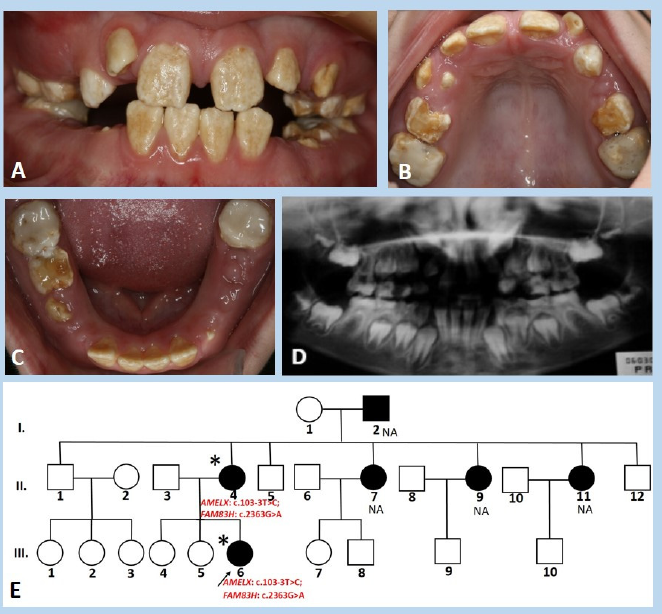
Figure 1. Clinical photographs, panoramic radiograph, and pedigree of the girl from family I. ( A – C ) Mixed dentition of the 9-year-and-10-month-old probed (III.6) reveal the chalky-white to yellowish hyperplastic enamel of all deciduous and permanent teeth. On the occlusal surfaces of upper and lower deciduous molars and permanent first molars, profound attrition is observed. Permanent first molars are covered with extensive glass ionomer fillings. All first deciduous molars and the lower right second deciduous molar were extracted. Both upper lateral permanent incisors are erupting ectopically. ( D ) Panoramic radiograph shows the presence of all permanent germs (wisdom teeth included). Those teeth that have developing tooth crowns not erupted exhibited normal anatomy, with enamel of normal thickness but lacking contrast between enamel and dentine. ( E ) Pedigree of family I shows the presence of an X-linked mode of inheritance. The arrow indicates the girl described (III.6); the symbol (*) indicates participating individuals; NA indicates not-available family